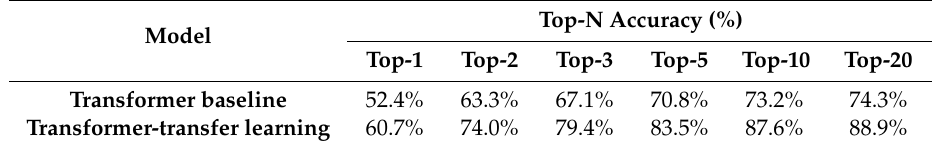
Table 3. Comparison of the top-N accuracies a of the Transformer and Transformer-transfer- learning